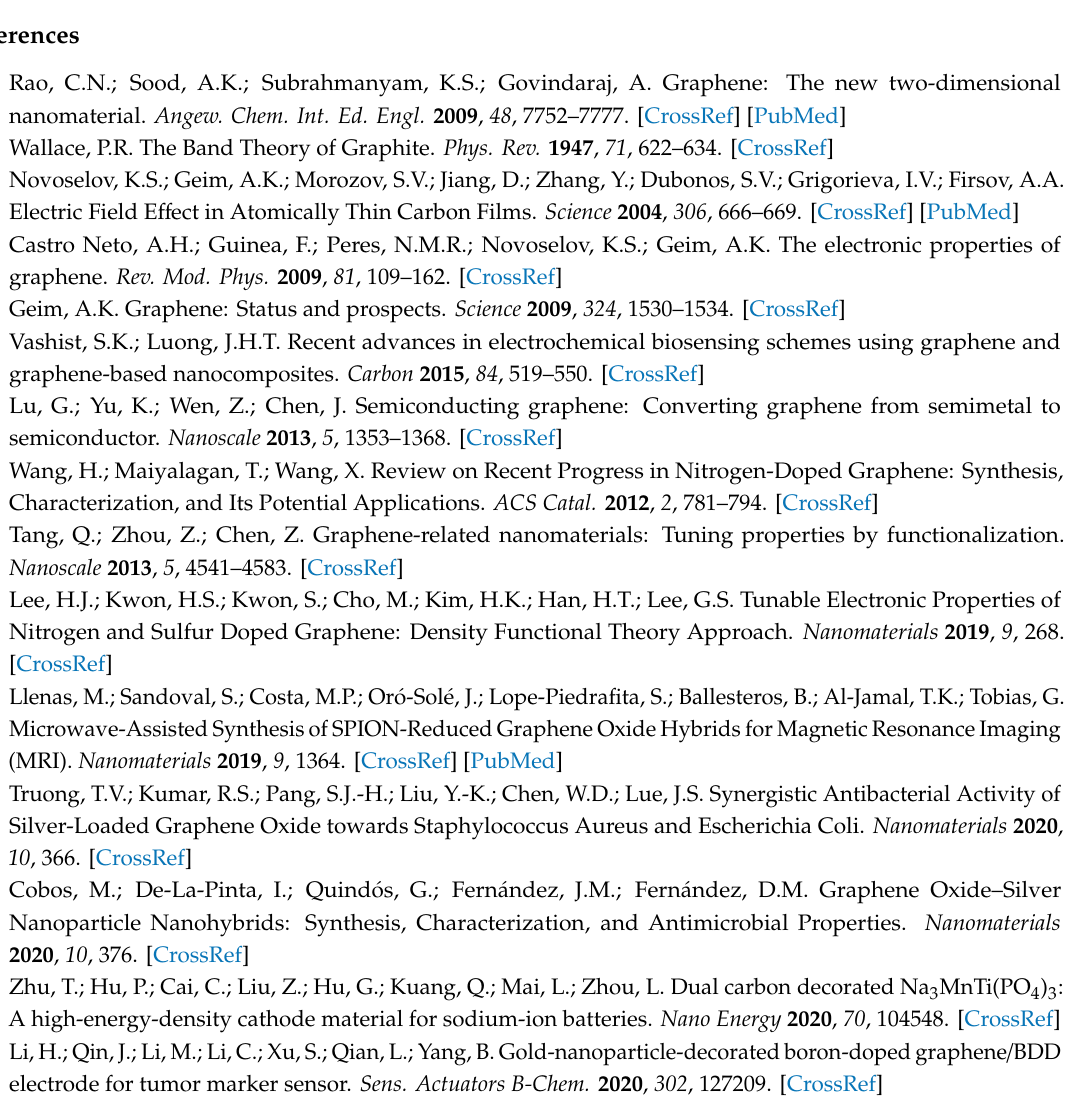
Figure S1. SEM and statistical data, Figure S2. High resolution C1s XPS, Figure S3. High resolution N1s XPS, Figure S4. TGA, Table S1. Description of the synthesized samples, Table S2. Distribution of di ff erent functionalities observed after deconvolution of high-resolution C1s XPS signal and Table S2. Onsets of